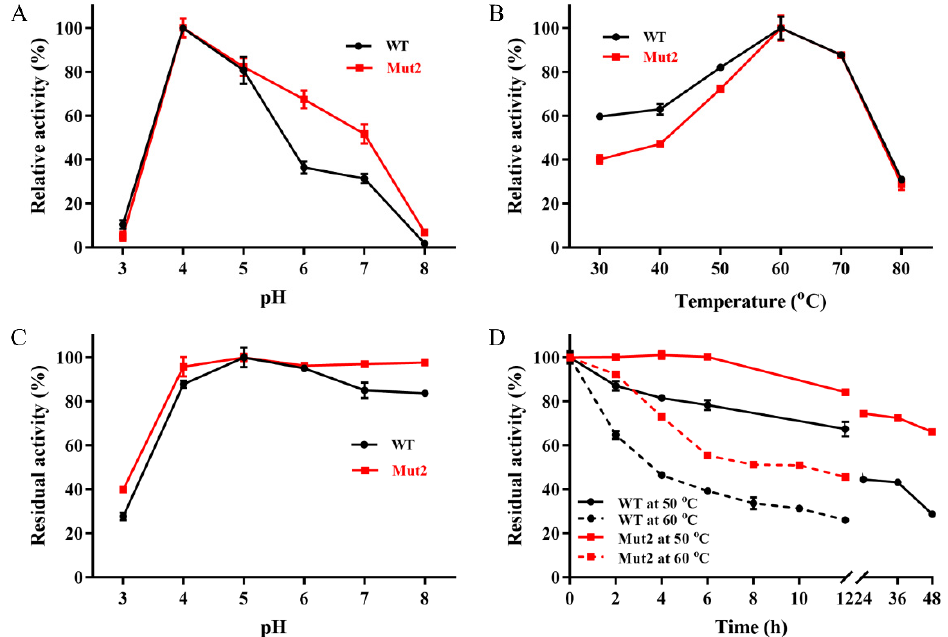
Figure 3. Effects of pH and temperature on the activity and stability of Ghlac. ( A ) The optimal pH ( A ) and temperature ( B ) for Ghlac. Effect of pH ( C ) and temperature ( D ) on the stability of Ghlac. The t 1/2 values of WT and Mut2 at 50 °C were 21.9 h and 80.6 h, respectively. The t 1/2 values of WT and Mut2 at 60 °C were 3.6 h and 9.8 h, respectively.